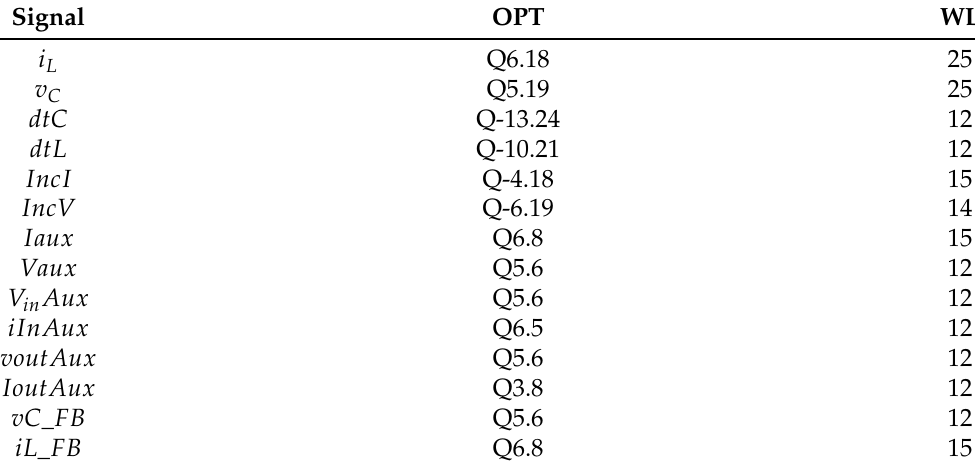
Table 1. Optimal fixed-point NF and word lengths for each of the signals involved in the buck’s HIL model (see Figure 2 according to the methodology described